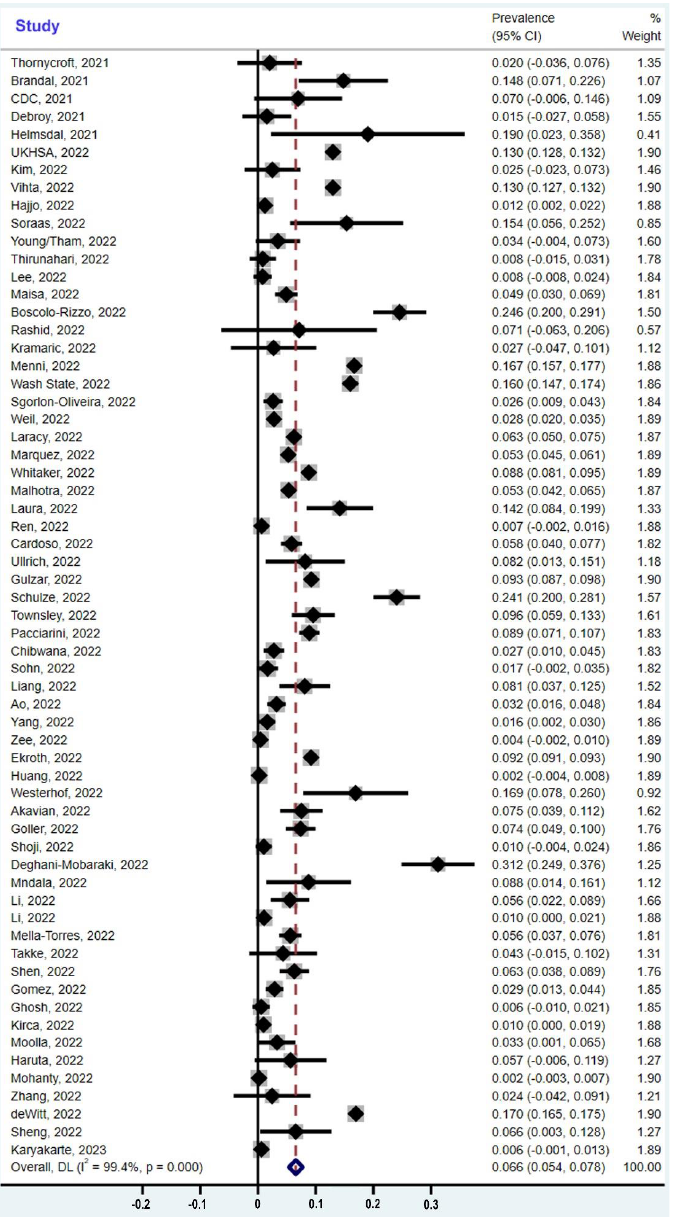
Figure 3. Forest plot of the 62 studies reporting the prevalence of olfactory dysfunction due to the omicron variant. The confidence intervals (CI) and the weight of each study are indicated on the right. The pooled overall global prevalence is 6.6% according to the meta-analysis, but this does not consider ethnic differences and population sizes as explained in Figure 4. The size of the light-grey box is proportional to the study weight. The study weights are obtained based on the DerSimonian–Laird method. CI, confidence interval; DL, DerSimonian–Laird method; I 2 , I-squared